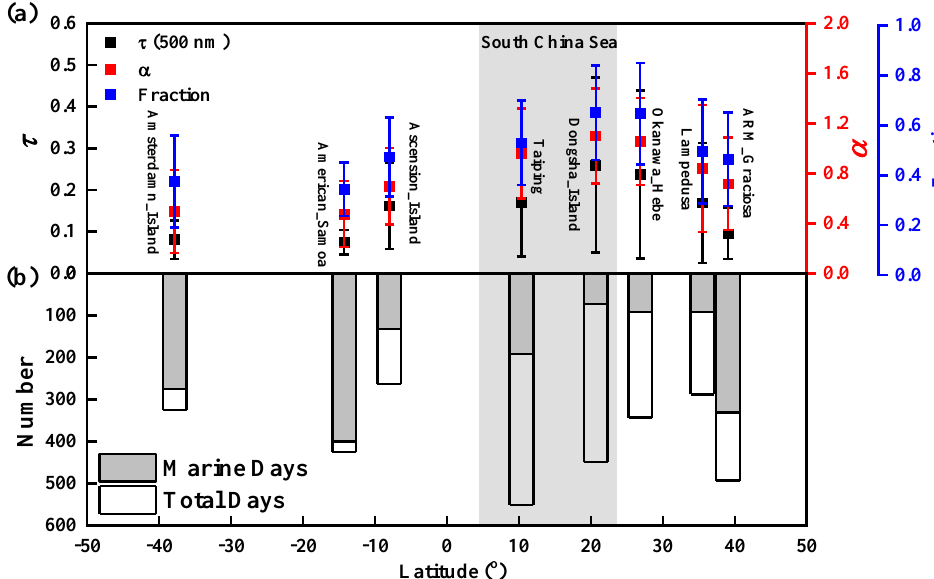
Figure 4. Global annual average, meridional distributions of ( a ) τ at 500 nm, α (440–870 nm), FMF; ( b ) the total number of samples and pure maritime days.